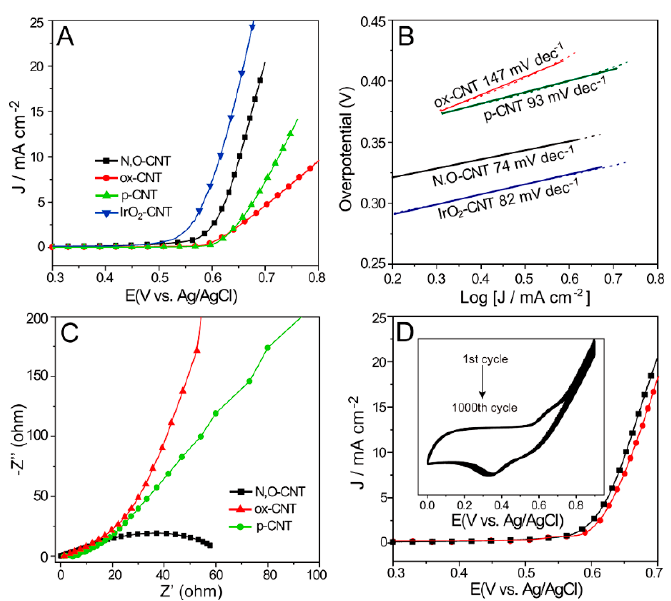
Figure 5. ( A ) Oxygen evolution reaction (OER) LSVs at a sweep rate of 5 mVs − 1 and ( B ) OER Tafel plots of p-CNT, ox-CNT, N, O-CNT, and IrO 2 -CNT. ( C ) The electrochemical impedance spectra (recorded at 0.65 V) of p-CNT, ox-CNT, and N, O-CNT. ( D ) Electrochemical durability test of N, O-CNT for OER, the LSV plots before and after 1000 cycles, and inset are the CV plots at 50 mV s − 1 for 1000 cycles. ( A ) The overall LSV curve of N, S-CN in the potential range of − 0.8 to 0.8V, ∆ E (E j=10 − E j= − 3 ) is a metric for bifunctional ORR and OER activity (Inset: The value of ∆ E for various catalysts reported previously).